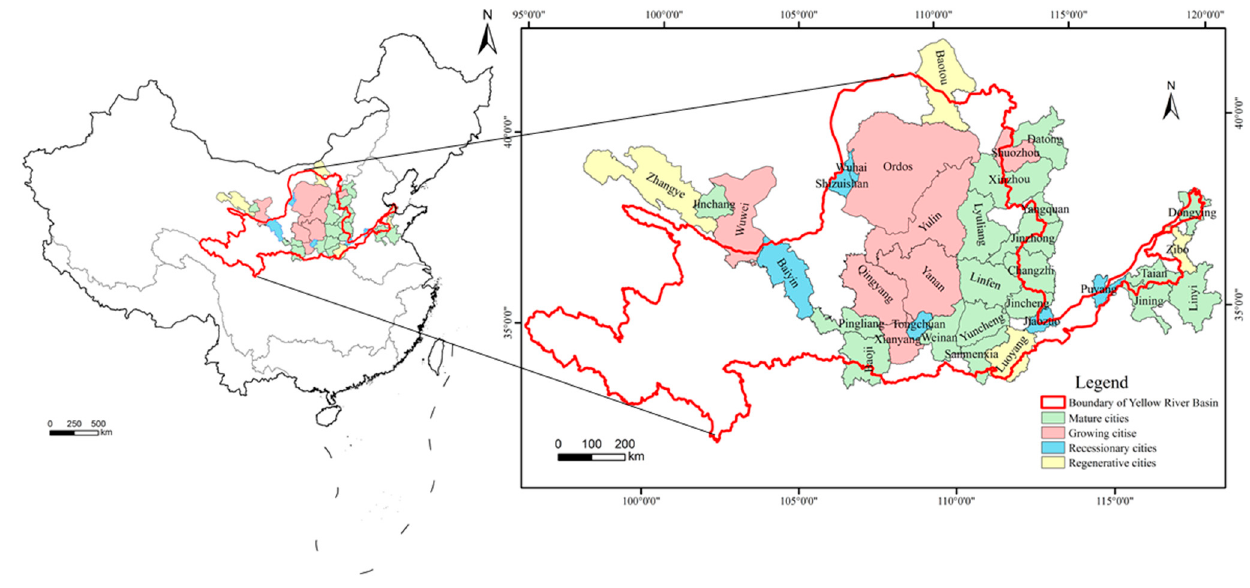
Figure 1. Location of resource-based cities in the YRB.